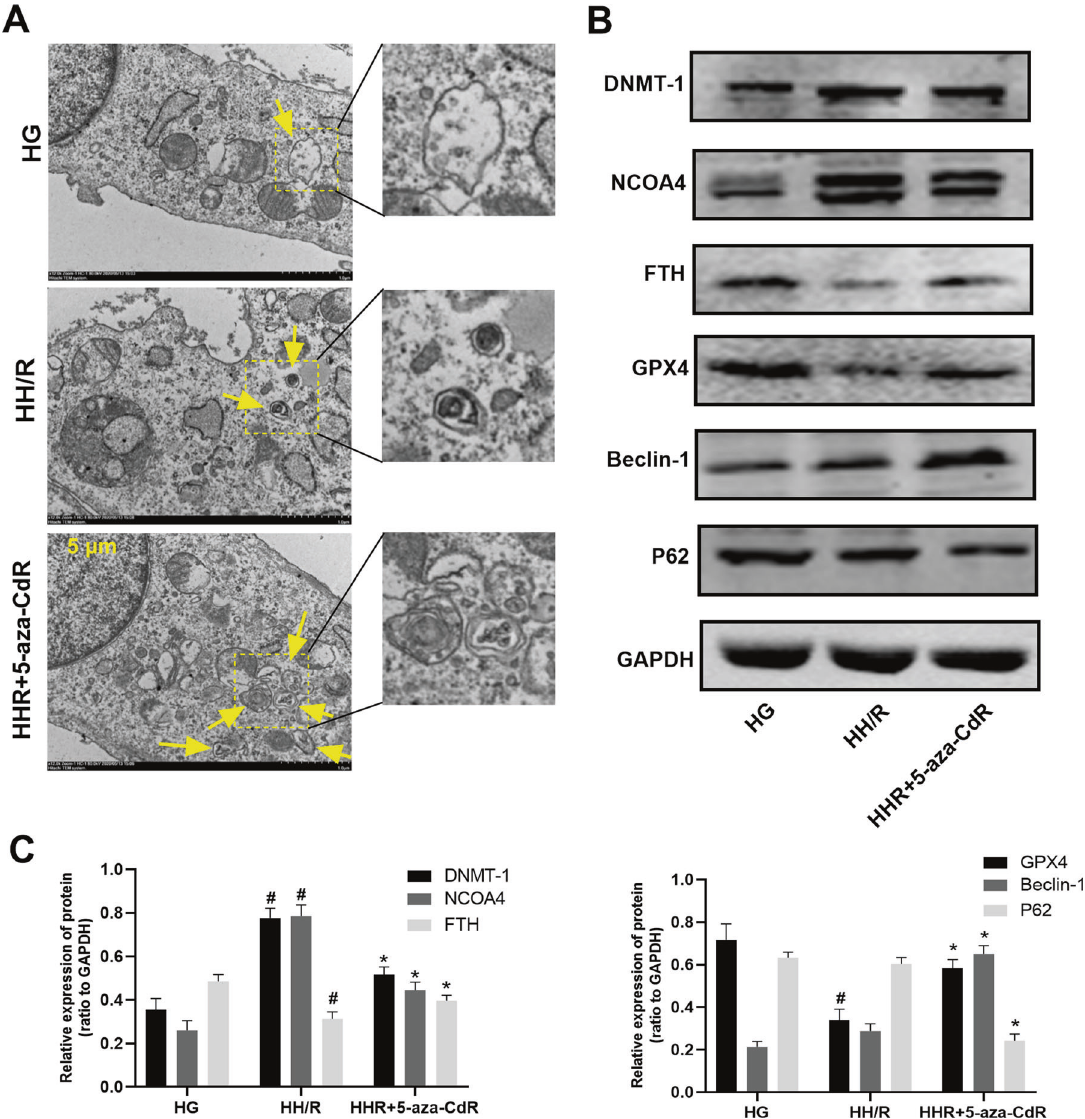
Fig. 5 Effect of DNMT-1 on the autophagy-ferroptosis axis of HH/R H9c2 cells. A The changes of autophagosome in H9c2 cells were detected by electron microscopy. B , C The protein expression of DNMT-1, NCOA4, FTH, GPX4, Beclin-1, and p62 in H9c2 cells was detected by western blotting. Results are presented by means ± SD. n = 6 per group. # P < 0.05 compared with the HG group. * P < 0.05 compared with the HH/R